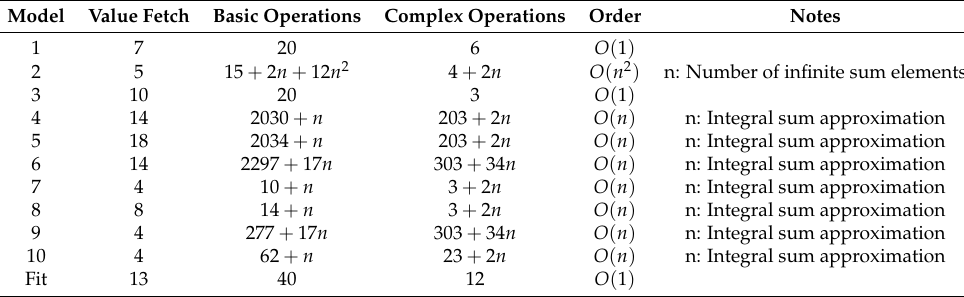
Figure 5. PER vs. SNR fitted curves against model curves with L = 500 bytes for Model 2 (Mahmood and Janti (9) considering constants of BER model (23)) and Model 6 (Song and Choi (12) with BER from (25)) in ( a ) linear scale and ( b ) logarithmic scale. Table 3. Complexity analysis